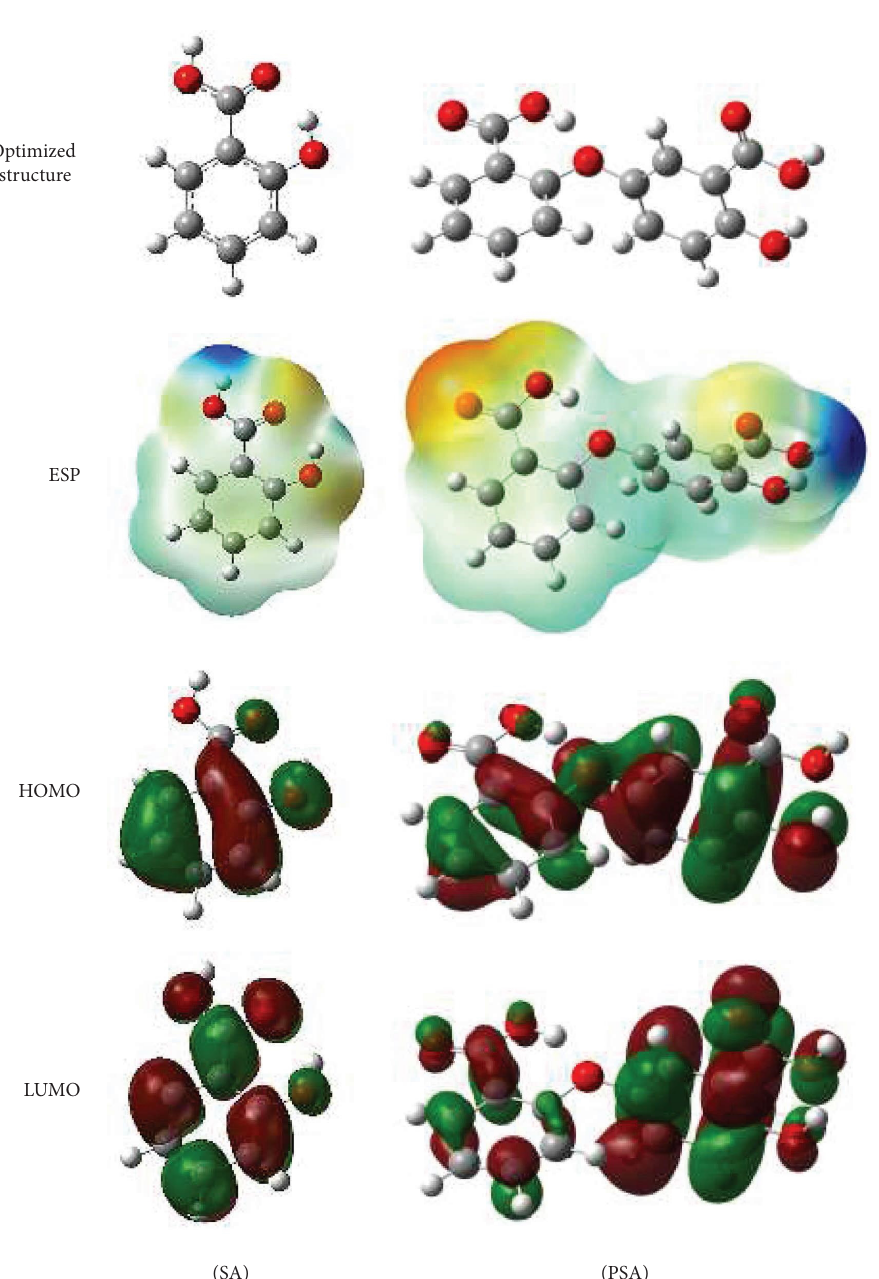
Figure 17: Optimized geometries, ESPs, and frontier molecular orbitals of SA and PSA.